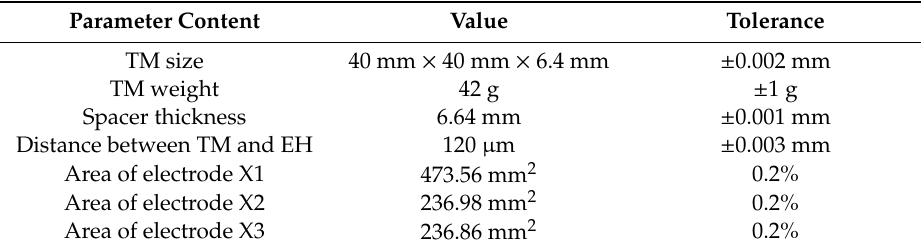
Table 1. Design parameters of the sensitive structure.